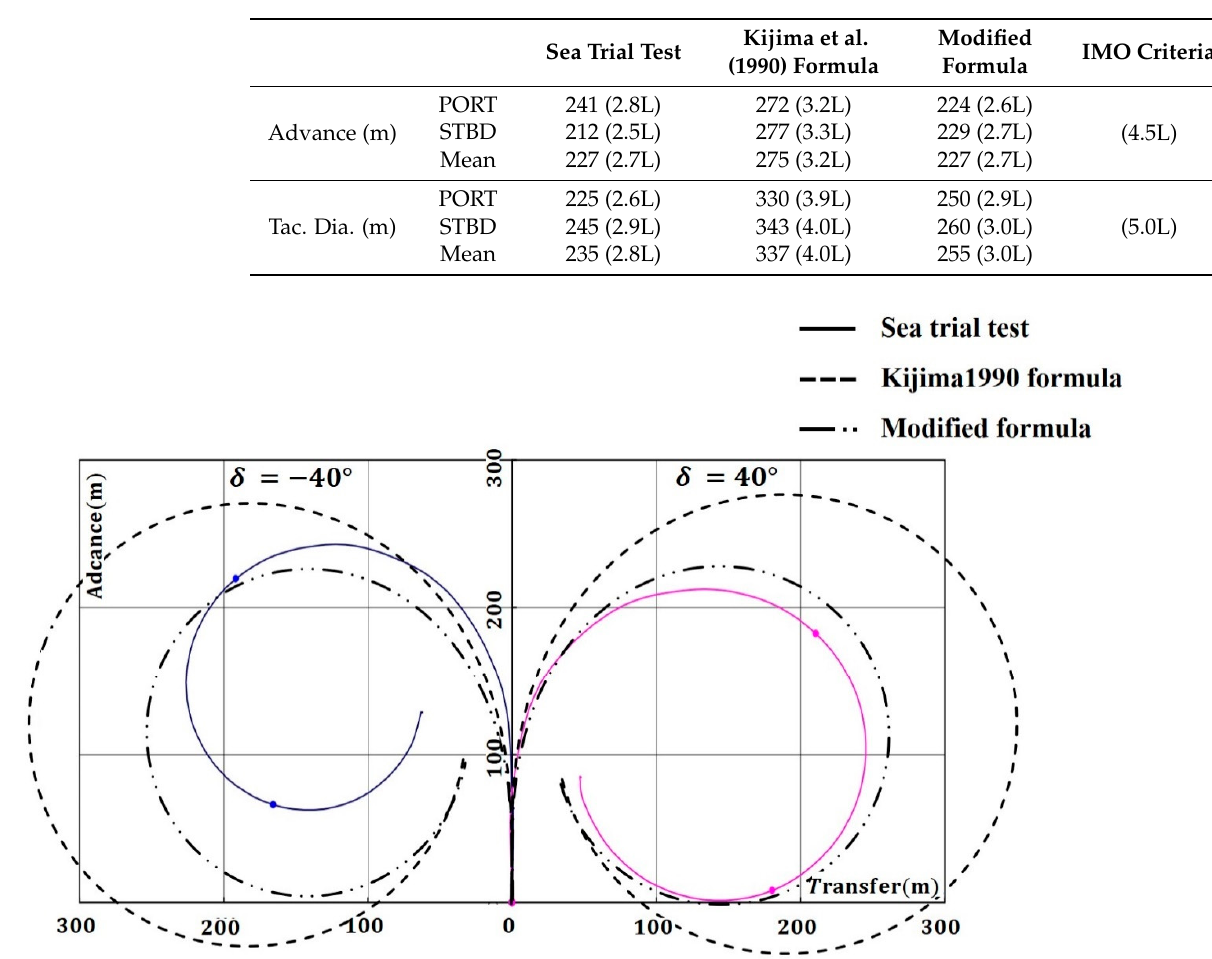
Figure 7. Comparison of the turning motion test results of the target